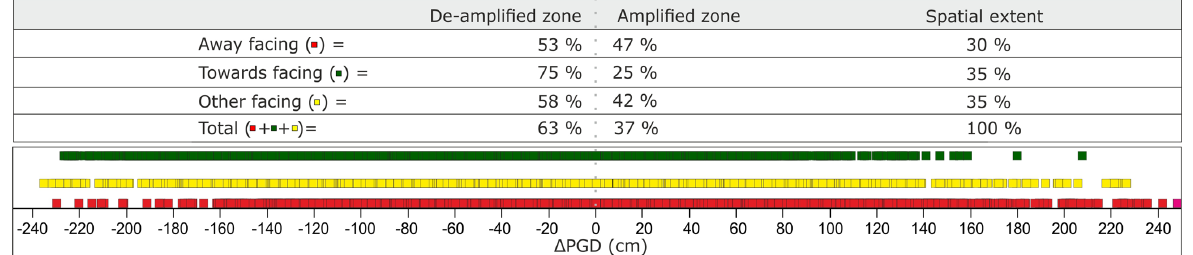
Figure 7. The difference in peak ground displacement ( (cid:49) PGD) between the models with and without topography (Fig. 4d) is compared with certain aspects of the study area. Aspects are categorized as away (facing away from the epicenter), towards (facing the epicenter) and other (facing a direction other than towards or away). The categorization is based on 60 ◦ offset of aspect with respect to its angle towards the